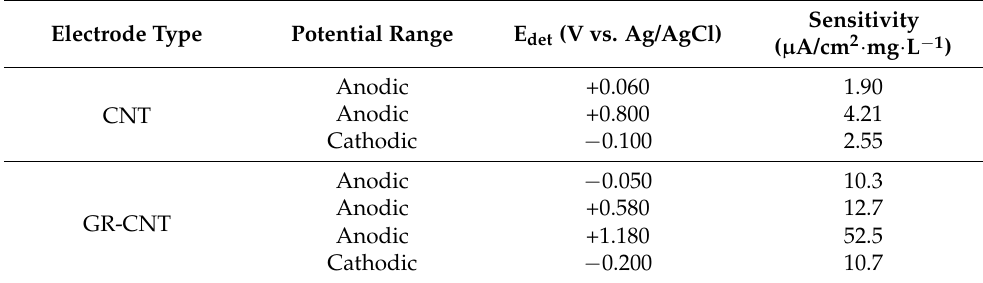
Table 3. Sensitivities and detection potential values for DCF determination with CNT and GR-CNT paste electrodes.